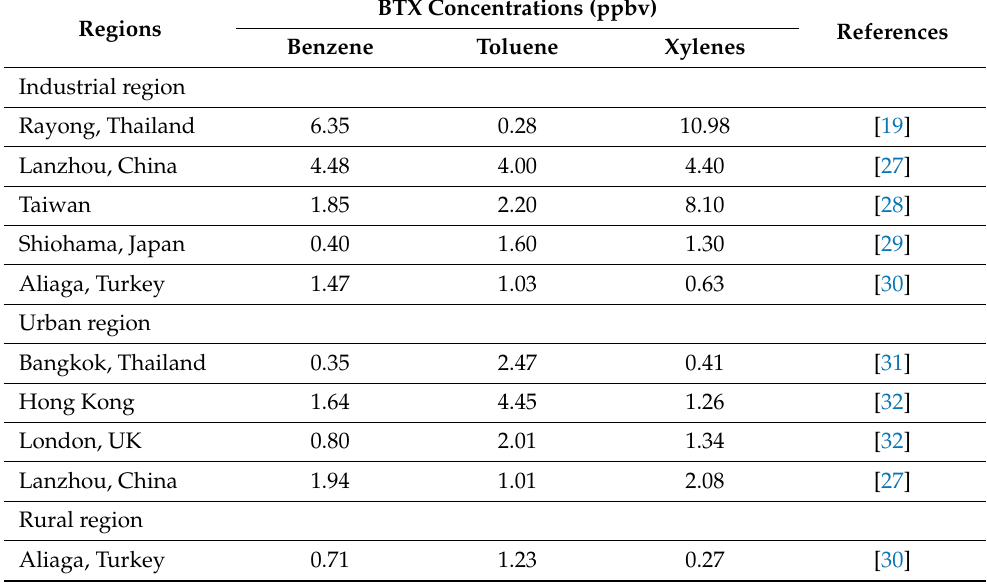
Table 1. Measured BTX concentrations (ppbv) in the different regions.